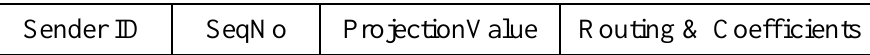
Figure 7. Packet structure.